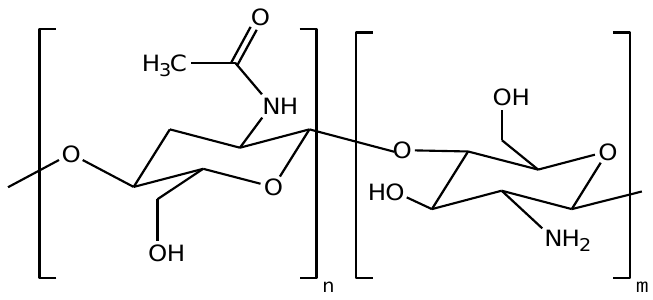
Figure 1. General chitosan chemical